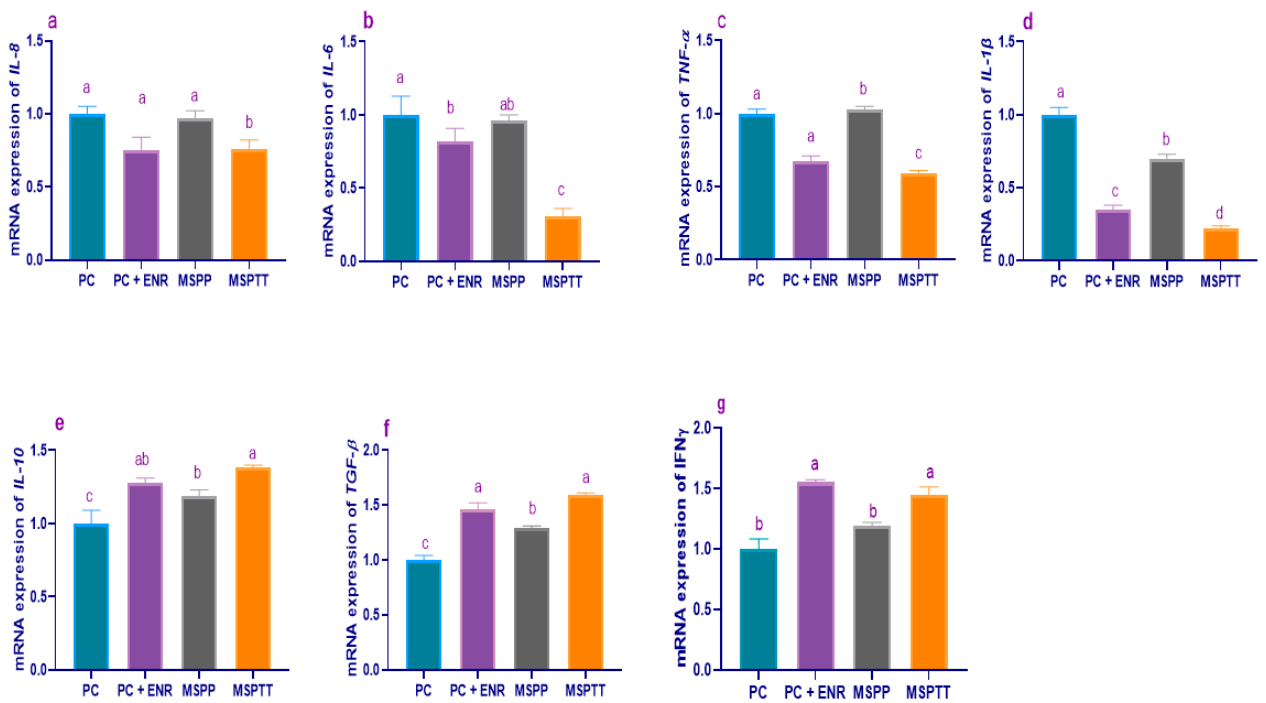
Figure 6. Levels of interleukin-8 ( IL-8 , ( a )), interleukin-6 ( IL-6, ( b )), tumor necrosis factor-alpha ( TNF- α , ( c )), interleukin-1-beta ( IL-1 β , ( d )); interleukin-10 ( IL-10, ( e )), transforming growth factor-beta-1 ( TGF- β 1, ( f )), and interferon gamma ( IFN γ , ( g )), mRNA expression in rabbits experimentally infected with L. monocytogenes and supplemented with multi-strain probiotics either used prophylactically and/or therapeutically and enrofloxacin treatment (at 90 d of age). MSP: multi-strain probiotics including Lactobacillus acidophilus NBIMCC 8242, Bacillus subtilis DSM 17,299, and Enterococcus faecium NBIMCC 8270. PC: positive control (rabbits fed a basal diet and experimentally infected with L. monocytogenes ); PC+ENR: rabbits fed a basal diet, experimentally infected with L. monocytogenes, and treated with enrofloxacin; MSPP: rabbits fed a basal diet supplemented with MSP at the level of 1 × 10 8 CFU/kg from 30 to 60 days of age and experimentally infected with L. monocytogenes ; MSPTT: rabbits fed a basal diet supplemented with MSP at the level of 1 × 10 8 CFU/kg from 30 to 90 days of age and experimentally infected with L. monocytogenes . Rabbits were orally administered with L. monocytogenes at the concentration of 10 7 CFU/mL at 60 days of age Values are means with their SE in bars. a–d : Means inside the same column having various superscripts are significantly different at p < 0.05.